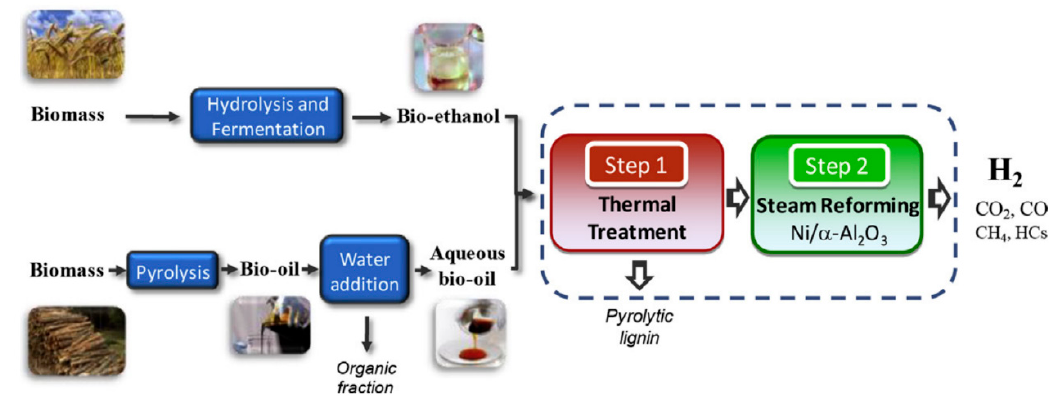
Figure 6. Hydrogen production layout according to the joint steam reforming of bio-oil and bio-ethanol obtained from biomass [29] .